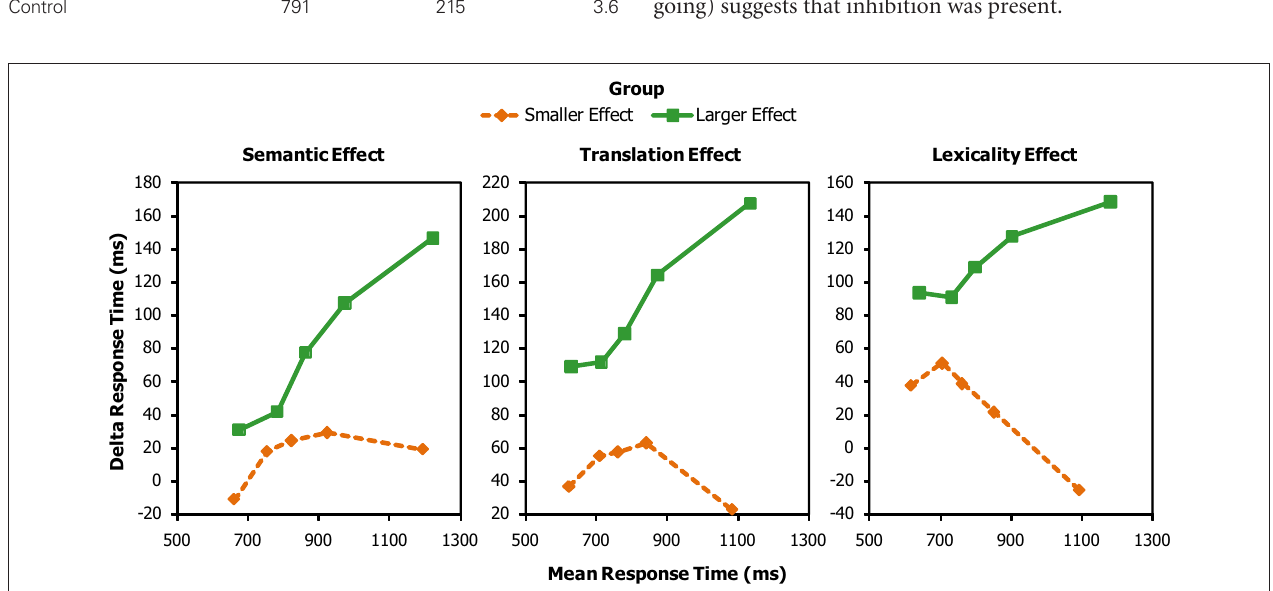
Figure 2 | Delta plots for the semantic, translation, and lexicality effects as a function of smaller and larger distractor effect size. The response time values on the horizontal axis for the delta plots are the means of the response times in the two conditions used to compute each